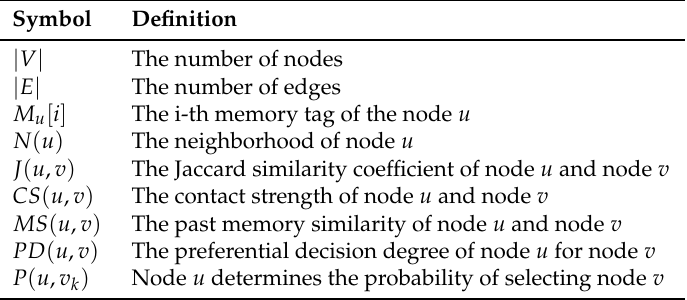
Table 1. A summary of the